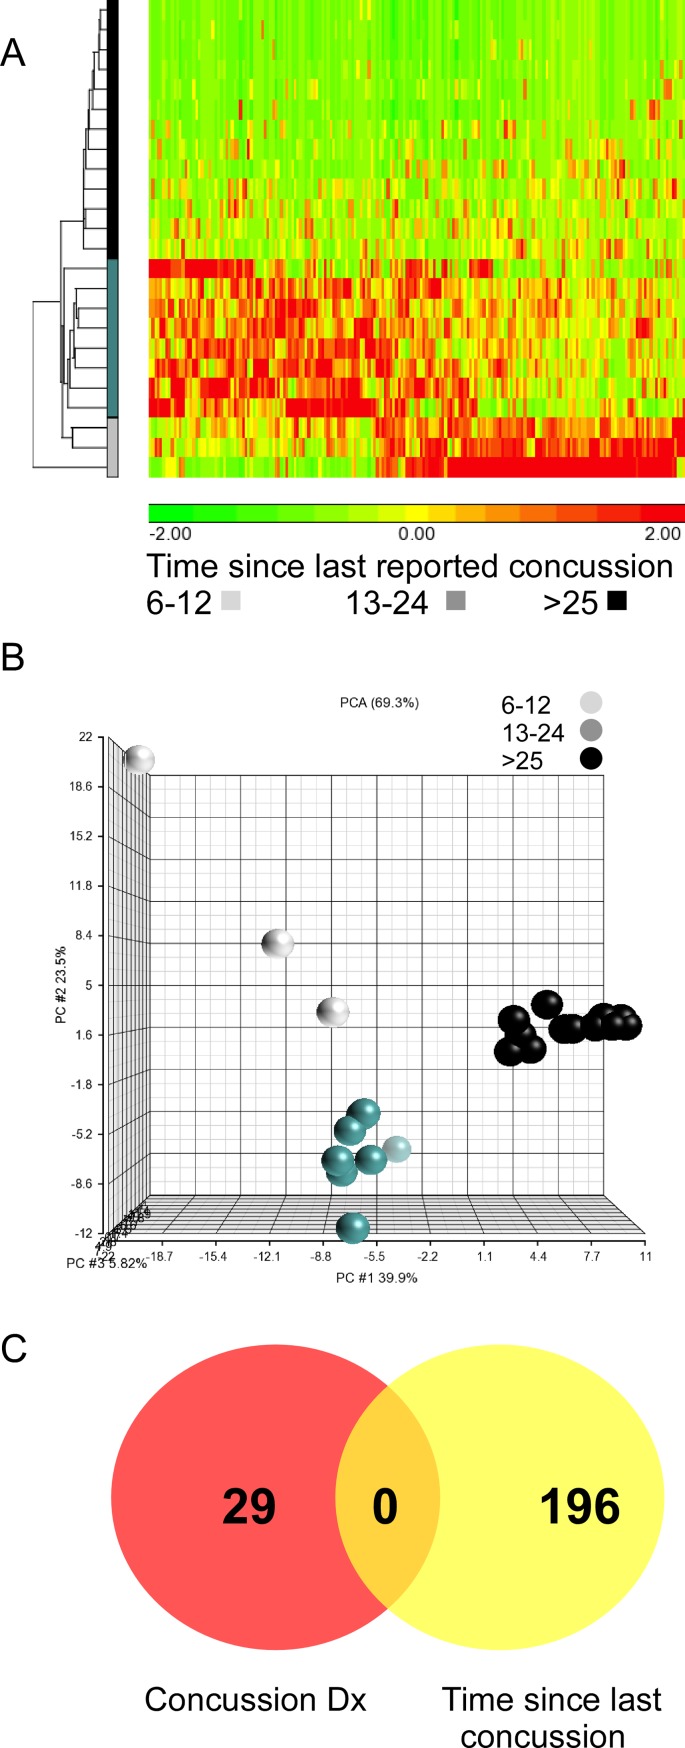
Exon expression pattern of concussion duration.A. Hierarchical clustering of patient’s time since last concussion based on 196 exons. B. Principle component analysis plot shows separation of data based on duration since last concussion. C. Venn diagram shows no overlap of regulated exons between concussion diagnosis and time since last injury.